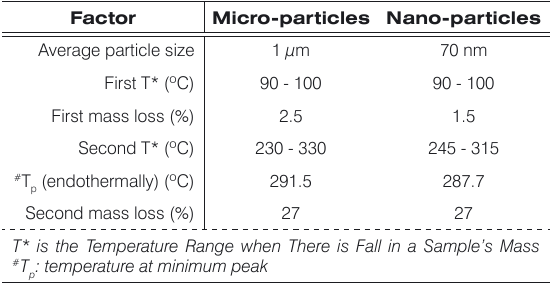
Table 1. Summary of DTA-TG